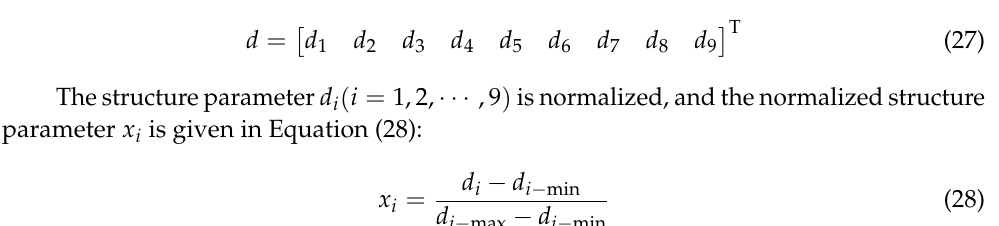
the i th normalized structure parameter. f ij ing to the interaction of the i th normalized structure parameter and the j th normalized structure parameter; the rest of the high-order terms of the function are obtained by analogy. The integral of sub-functions of the high-dimensional model representations concerning its variable is